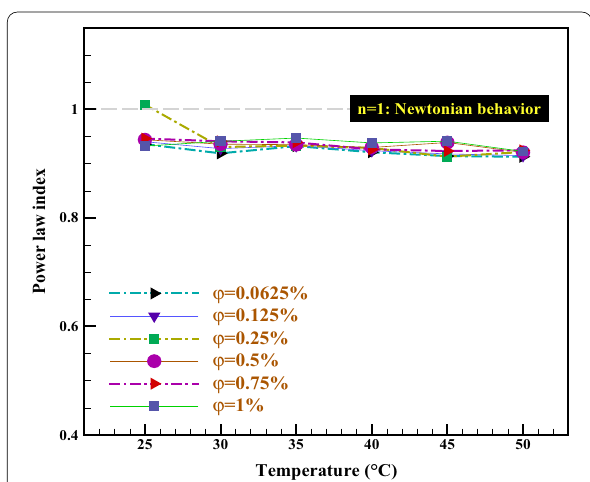
Fig. 7 Effect of temperature and φ on power-law index